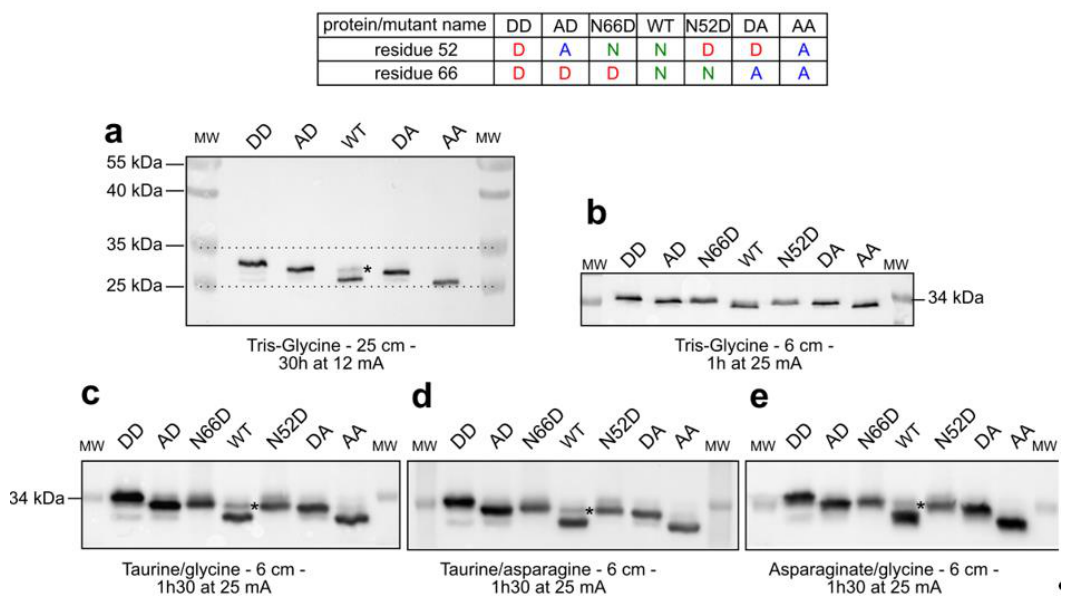
Figure 1. Separation of deamidated mutants of Bcl-x L on different polyacrylamide gels: Total proteins were extracted from HCT116 expressing the indicated forms of Bcl-x L , and 25 µg were separated by standard tris – glycine PAGE on a 25 cm-long gel for 30 h ( a ) or 6 cm-mini gels of the indicated compositions for 1 h 30 min ( b – e ). * indicates the modified form of Bcl-x L identified as N52-monodeamidated Bcl-x L according to migration distances.